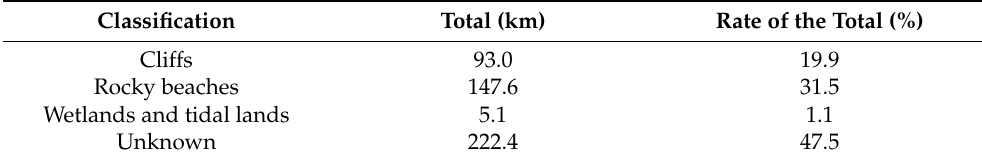
Table 3. Number of gaps and their areas in the non-surveyed (estimated) coastlines in Japan (the section of sea-based measurement).